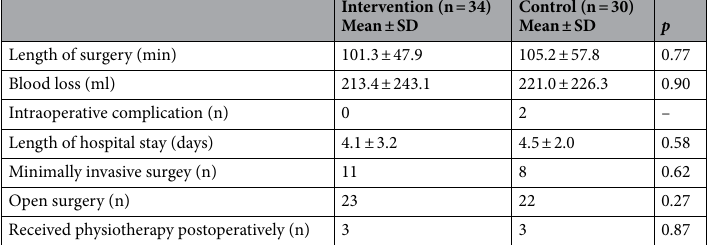
Table 4. Perioperative data. Physiotherapy consisted of one hospital-based or home-based visit to ensure adequate independency. The intraoperative complications were dural